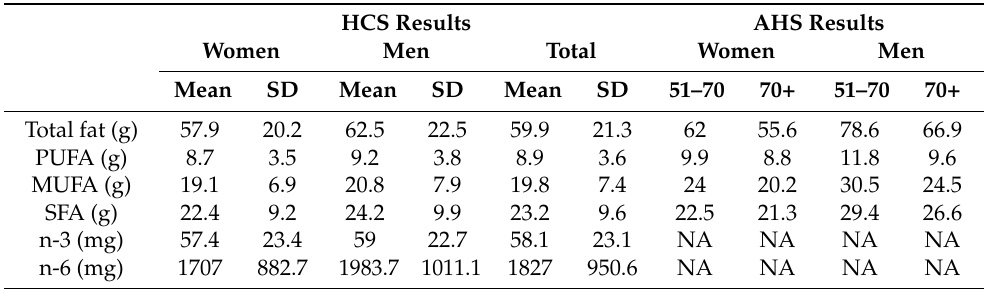
Table 2. Mean fatty acid intakes (standard deviation) comparison of the HCS and derived intake from the 2011–2012 Australian Health Survey (AHS) [34].